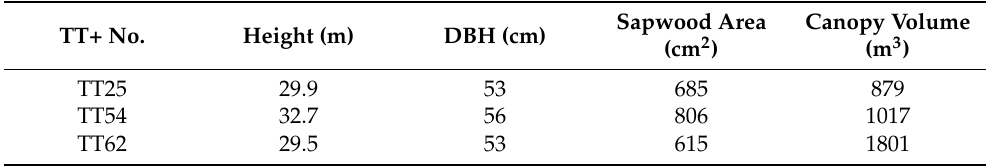
Table 1. Height, diameter at breast height (DBH), sapwood area, and canopy volume for the selected trees for individual responses.